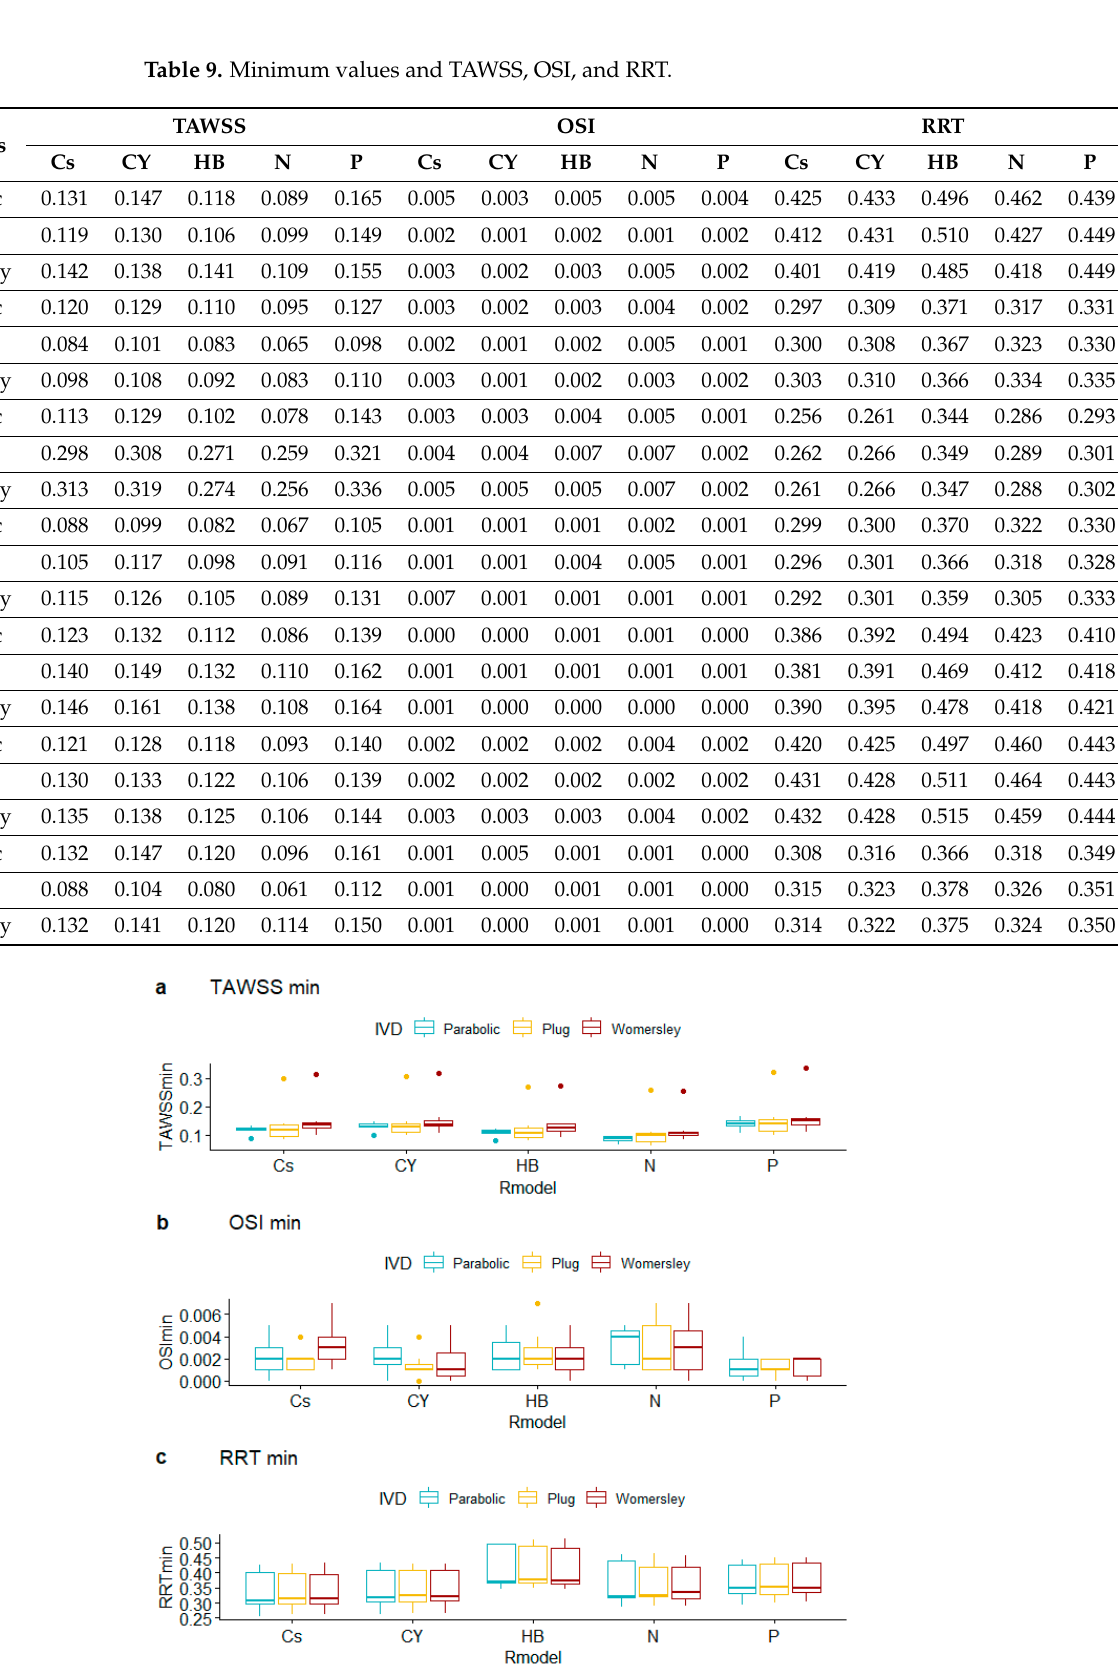
Table 9. Minimum values and TAWSS, OSI, and RRT.